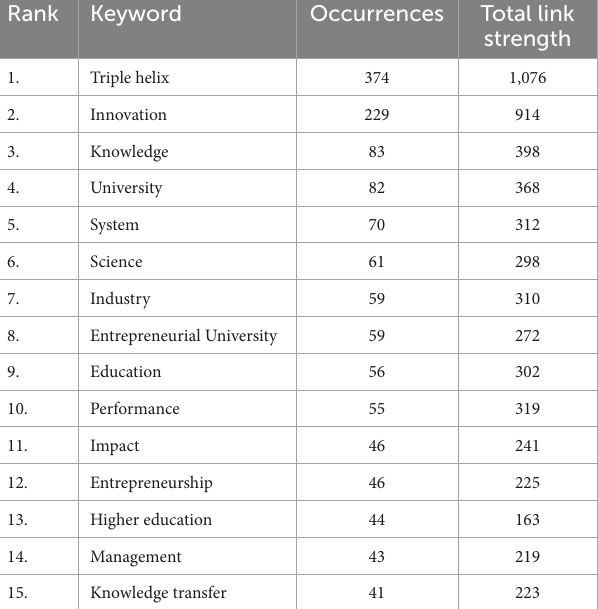
TABLE 6 Top 15 Helix model and education keywords